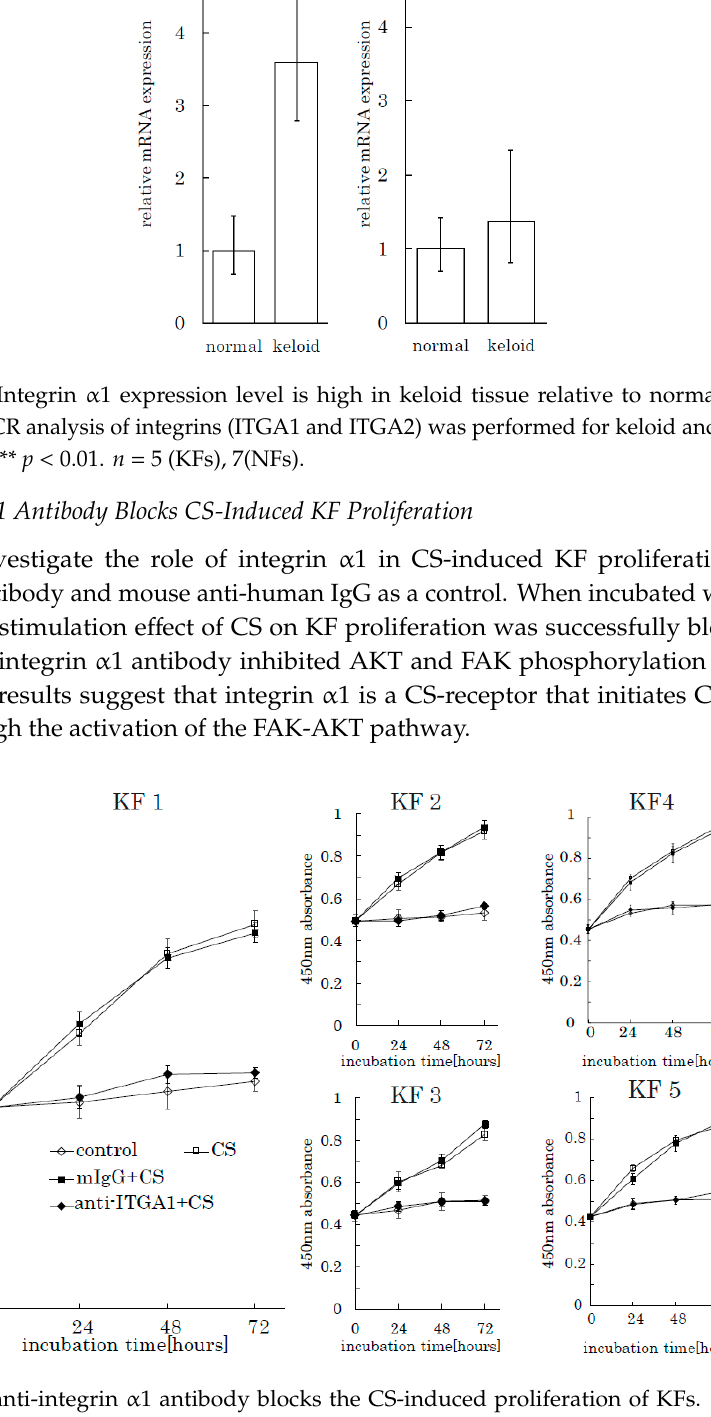
Figure 8. The anti-integrin α 1 antibody blocks the CS-induced proliferation of KFs. Proliferation rates of KFs incubated with CS in the presence of an anti-integrin α 1 antibody were analyzed. Mouse anti-human IgG was used as a control. Error bars represent the standard deviation ( n = 3).